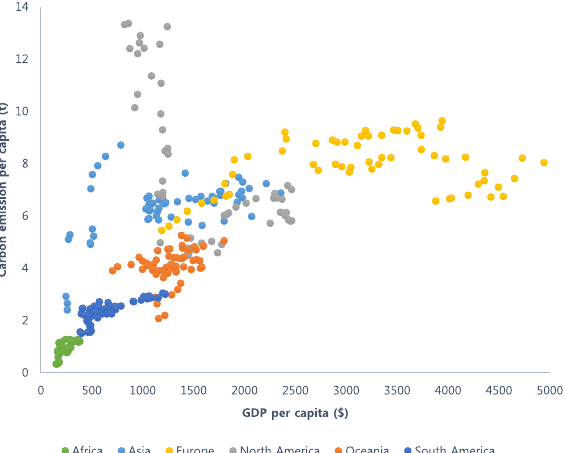
Figure 2. Environmental Kuznets curve ( EKC) grouped by continents. GDP, gross domestic